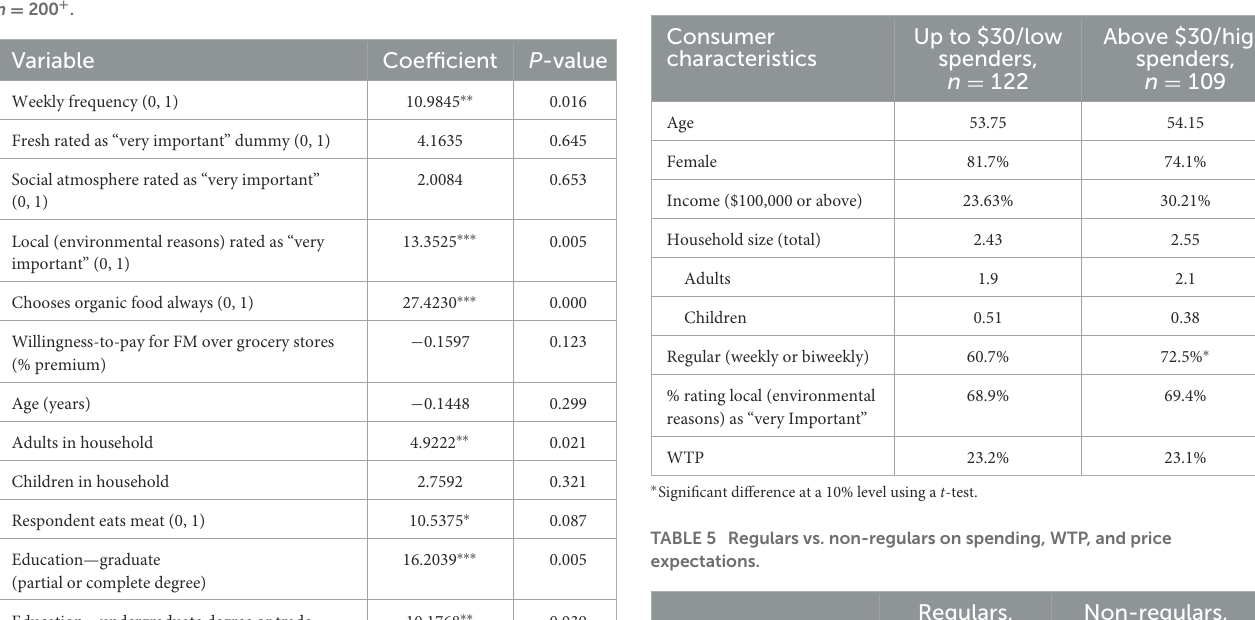
TABLE 4 Categories of spending.